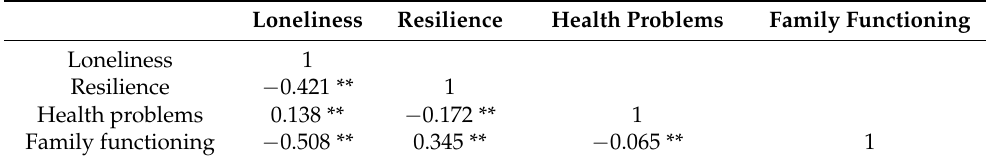
Table 4. Pearson’s r correlation matrix.